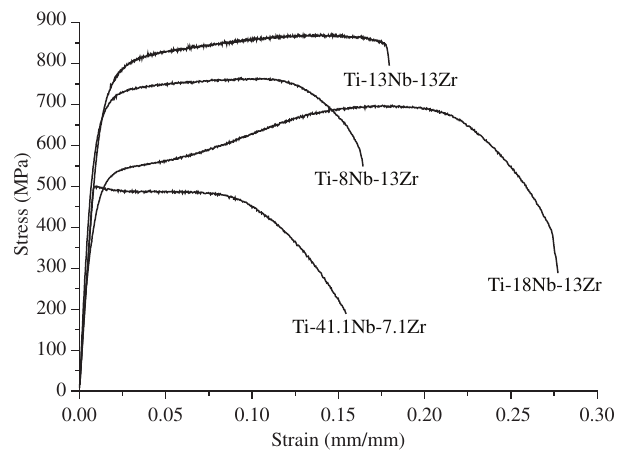
Figure 2. Full stress-strain curves for Ti-Nb-Zr alloys.